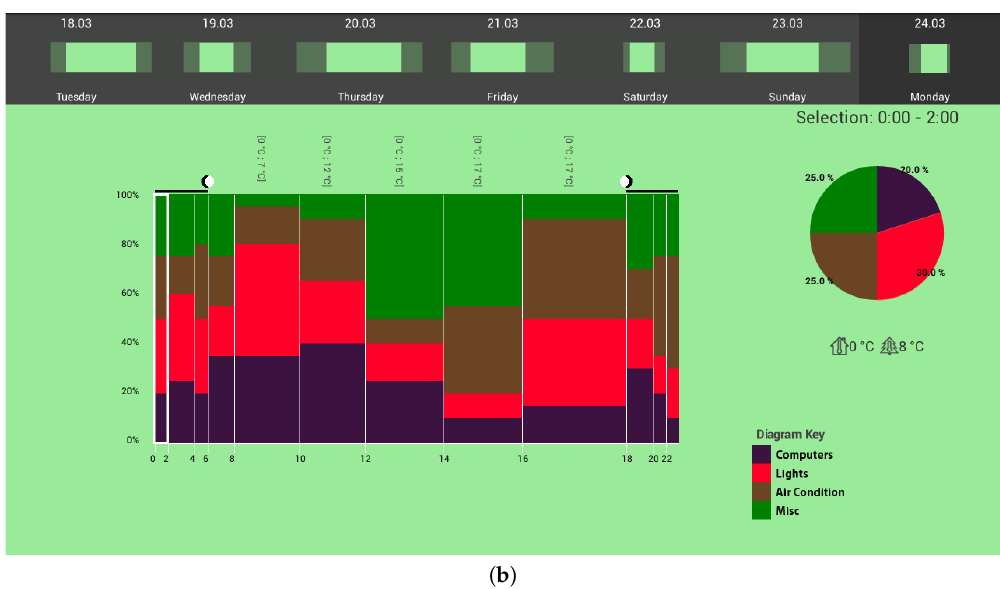
Figure 7. Examples of visualizations designed to support visual analytics of energy consumption data, showing time-pie ( a ) and its corresponding time-stack ( b ). Images from Reference